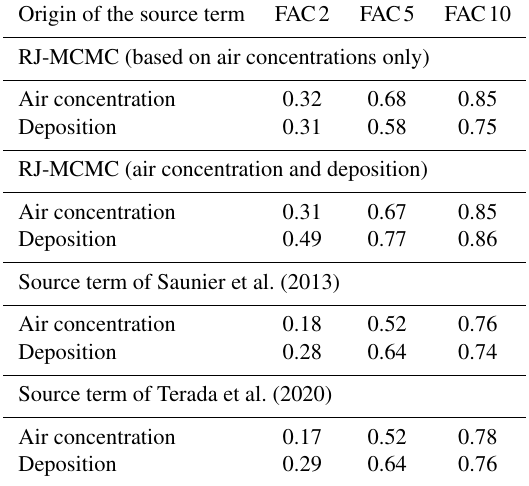
Table 2. Comparison of observed and simulated measurements from reconstructed predictions with air concentration measure- ments only or with air concentration and deposition measurements. The FAC2, FAC5, and FAC10 are the proportion of measurements for which the observed and modelled values agree by a factor of 2, 5, or 10 respectively. For example, the table reads as follows: the predictions calculated based on air concentrations only obtain a FAC5 score of 0.58 with respect to the deposition